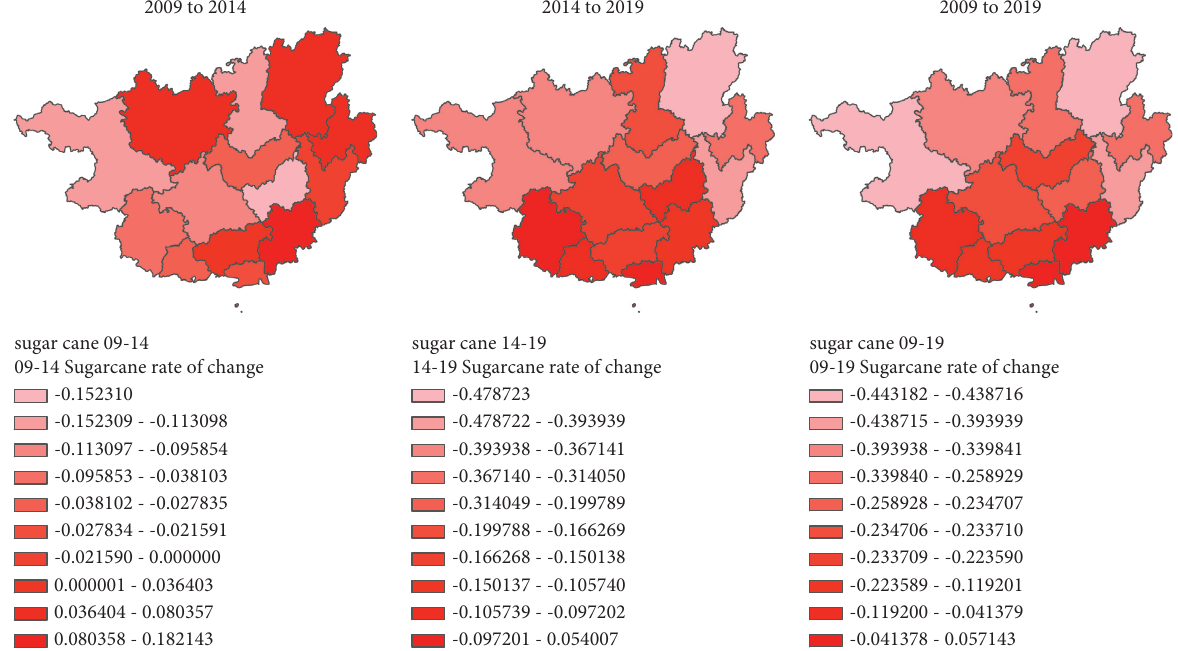
Figure 7: Change rate map of the proportion of sugarcane planting area in Guangxi from 2009 to 2019.